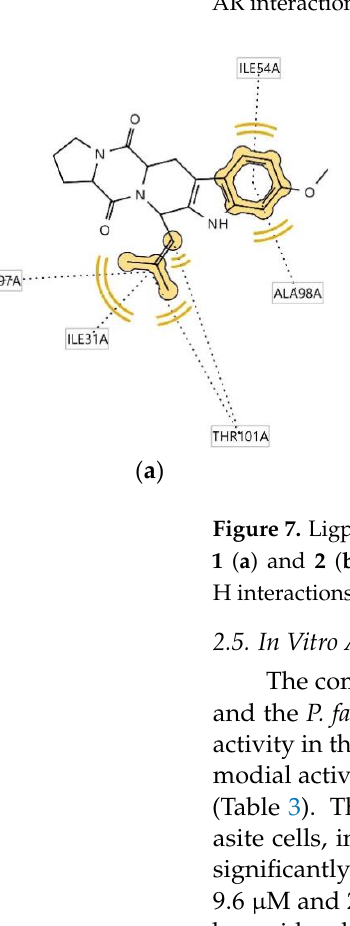
Figure 6. Ligplots showing interacting residues of cruzain complex with compounds 1 ( a ) and 2 ( b ). Red arrow dotted lines, HBAs; green arrow dotted lines, HBDs; Yellow lines, H; Purple arrows, AR interactions.